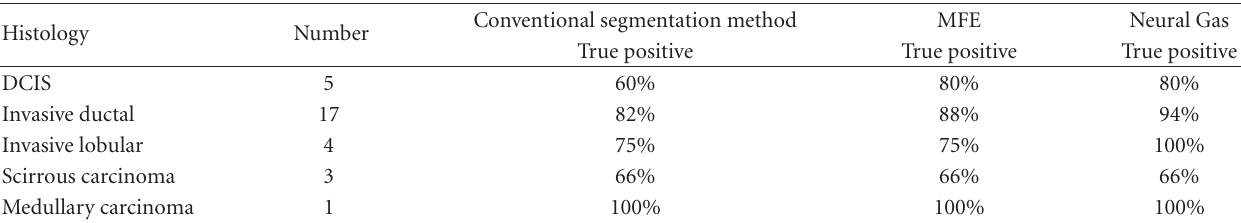
Table 3: Comparison of the conventional segmentation method and minimal free energy vector quantization and “neural-gas” network in the detection of malignant lesions.